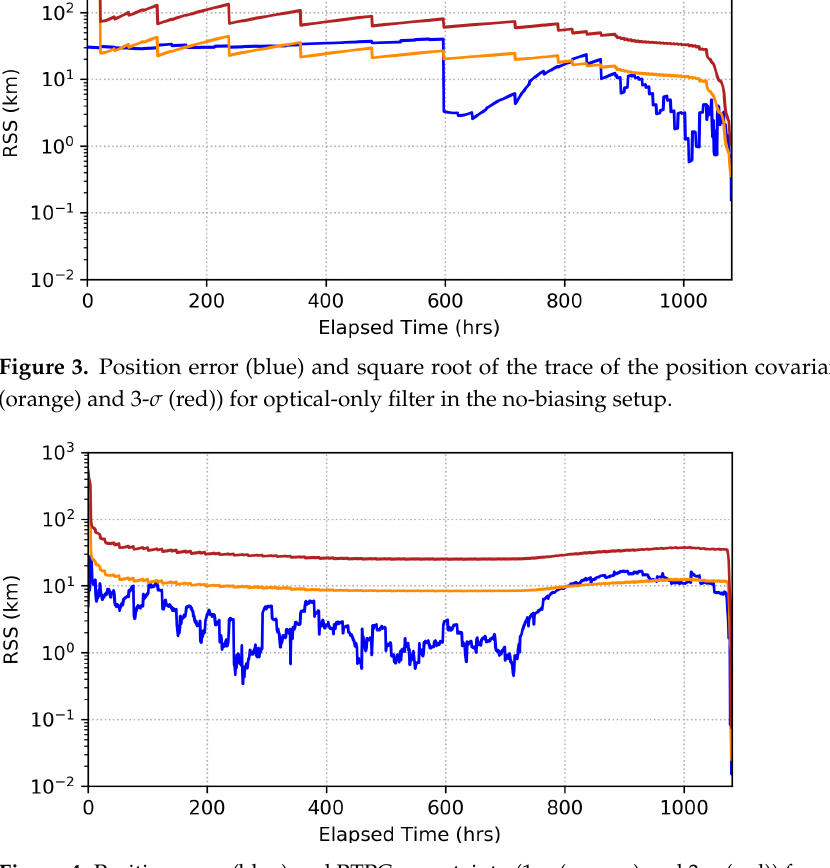
Figure 4. Position error (blue) and RTPC uncertainty (1- σ (orange) and 3- σ (red)) for radiometric-only filter in the no-biasing